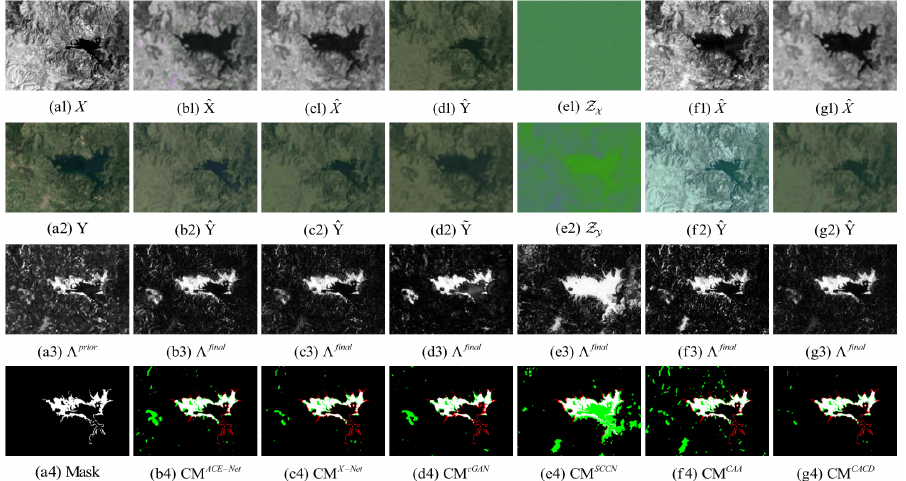
Figure 11. Sardinia dataset. ( a1 ) Input image X . ( a2 ) Input image Y . ( a3 ) Prior difference matrix generated by IRG-McS. ( a4 ) Real mask. ( b – g ) represent the results of ACE-Net, X-Net, cGAN, SCCN, CAA and CACD (US) methods, respectively. ( b1 , c1 , f1 , g1 ) transformed image ˆ X . ( d1 ) transformed Y domain image ˆ Y . ( e1 ) code image Z X . ( b2 , c2 , f2 , g2 ) transformed image ˆ Y . ( d2 ) approximate Y domain image ˜ Y . ( e2 ) code image Z Y . ( b3 , c3 , d3 , e3 , f3 , g3 ) final difference map. ( b4 , c4 , d4 , e4 , f4 , g4 ) confusion map, where white: true positives (TP), black: true negatives (TN), green: false positives (FP), red: false negatives